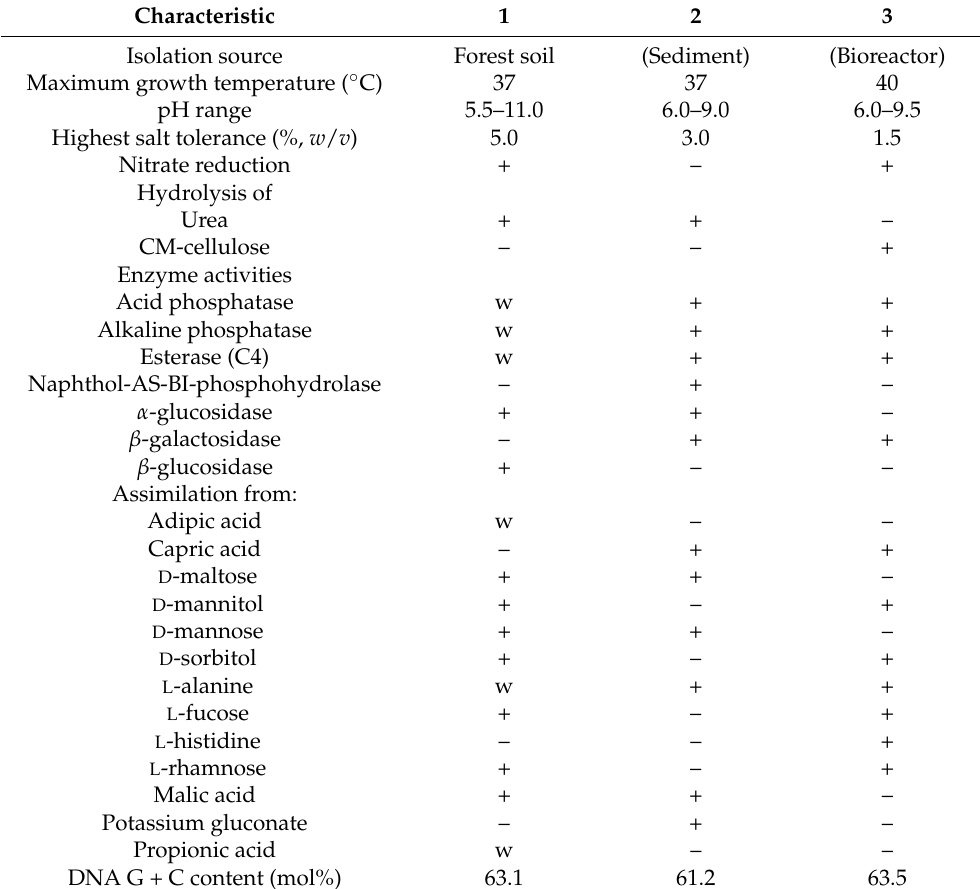
Table 3. Differential phenotypic characteristics of strain S-51 T with closely related species of the genus Rhizobium . Strains: 1, S-51 T ; 2, Rhizobium naphthalenivorans KCTC 23252 T [8]; 3,